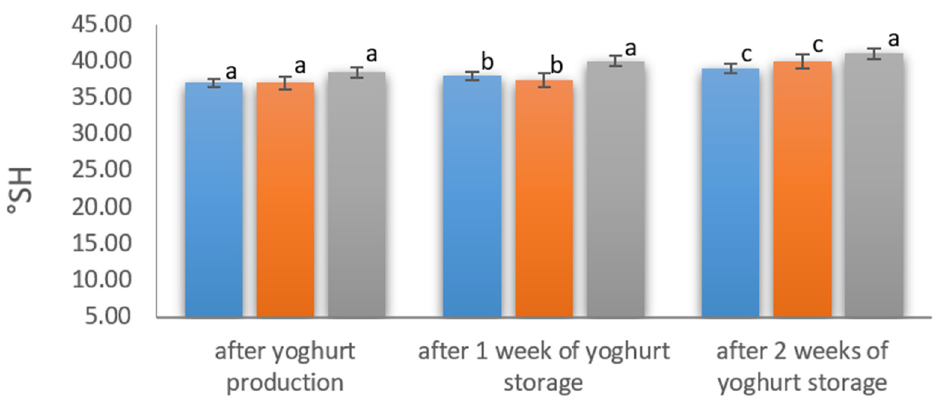
Figure 5. Changes in titratable acidity [°SH] during the storage of yoghurts fortified with the addition of 2% of skim milk powder [blue], casein hydrolysate [orange], and casein–iron chelate [grey] (mean values with different letters ( a,b,c , etc.) within a single-color component are statistically different ( p < 0.05)).